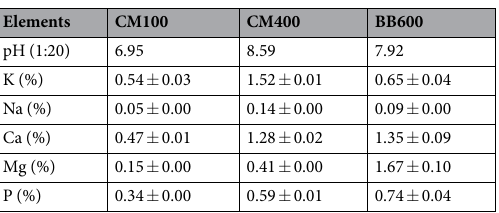
Table 1. The pH values and the elemental analysis of the cattle manure biochar (CM100 and CM400) and bamboo biochar (BB600). The numbers in the sample names represent the pyrolysis